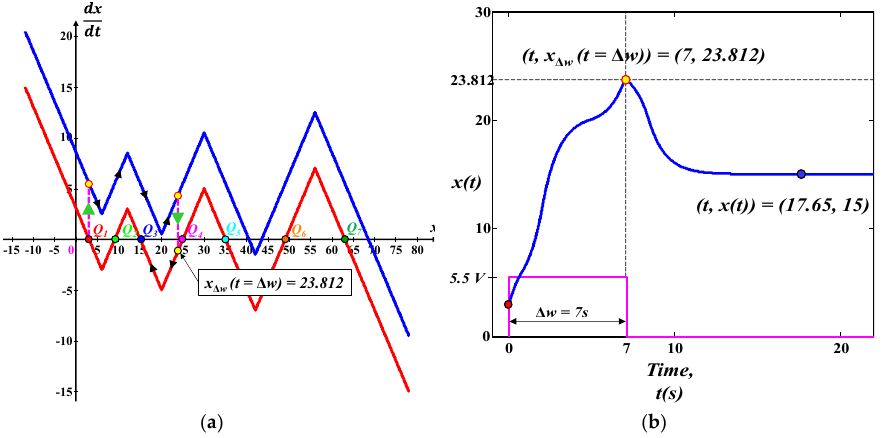
Figure 5. Switching failures of the 6-lobe corsage memristor from Q 1 to Q 5 for a pulse amplitude V A = 5.5 V and pulse width Δw = 7 s. ( a ) Dynamic routes of the switching kinetics, ( b ) movement of the exponential trajectories of x n (t) with respect to time, t. The switching failure happens due to insufficient pulse width.